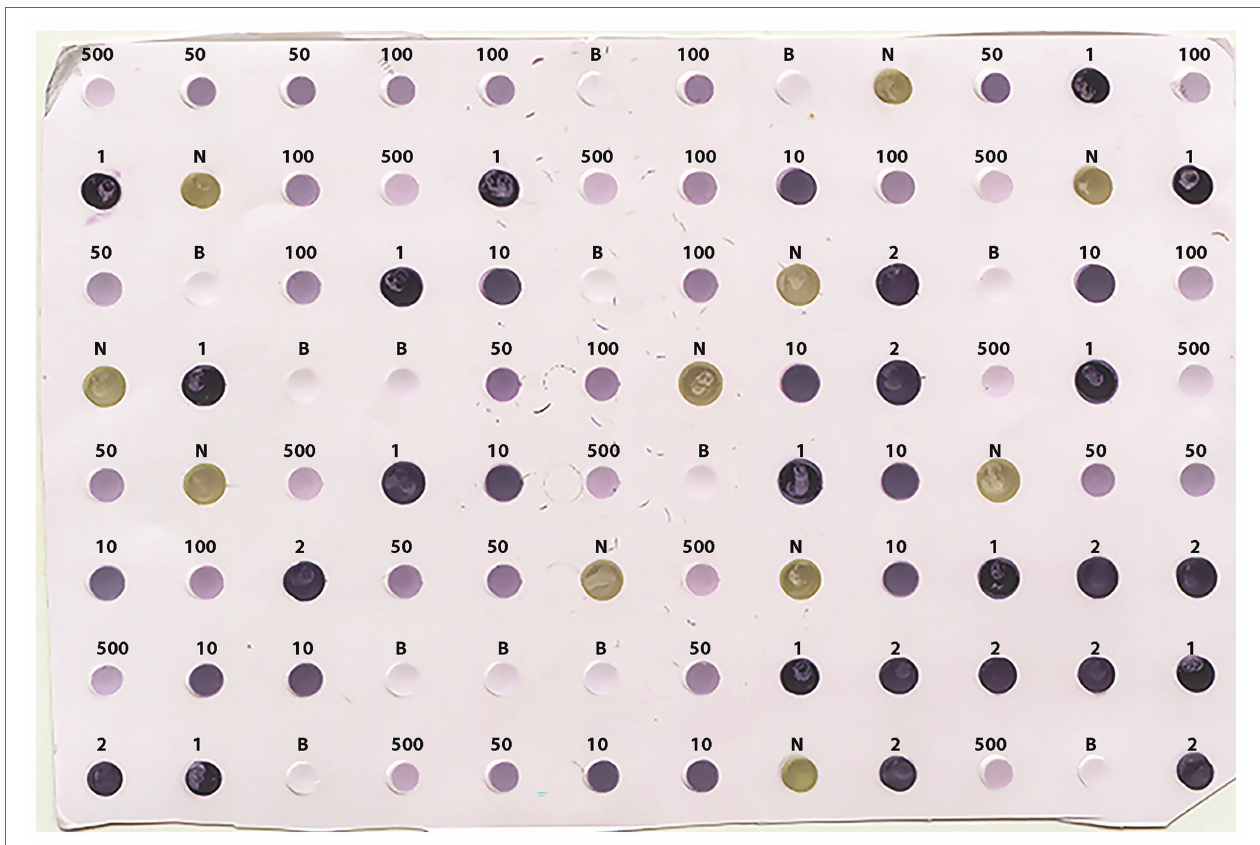
FIGURE 2 | Scanned image (at 150 dpi resolution) of the prototypic DE output used for training the classifier algorithm. Positive, negative, and buffer controls were randomly distributed on the membrane in 12, 11, and 13 replicates, respectively. The letters on top of the dots denote the Buffer (B) and the negative (N) controls, while the numbers 1, 2, 10, 50, 100, and 500 denote no dilution, or 1:2, 1:10, 1:50, 1:100, and 1:500 dilutions of the positive control (LBVaV virus standard, Prime Diagnostics, The Netherlands),